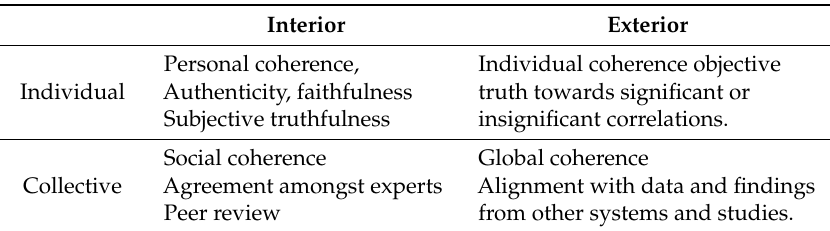
Table 5. Integral Coherence Model of Truth